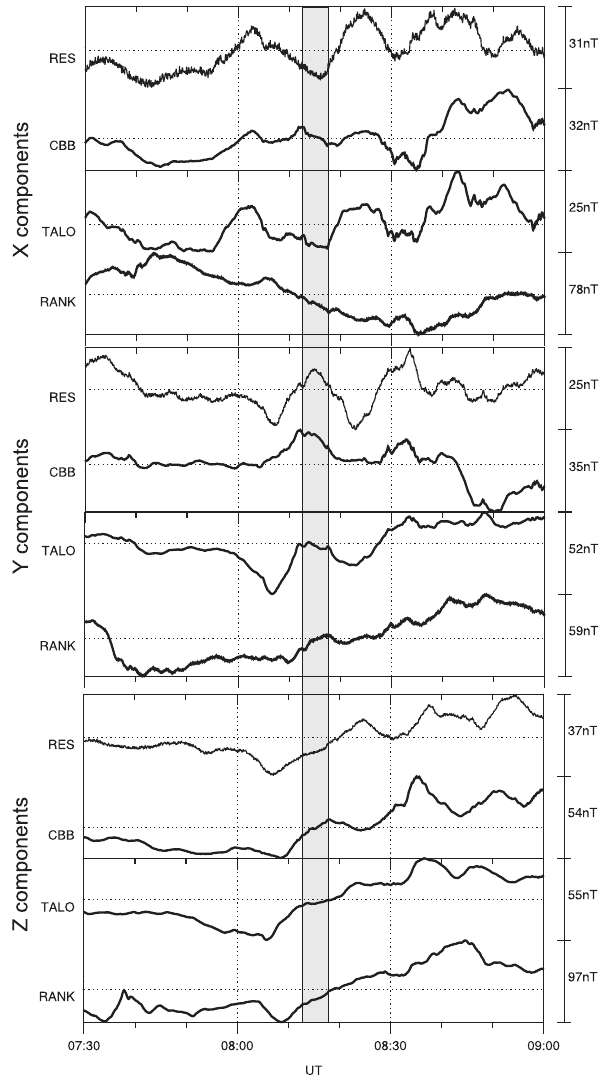
Fig. 9. X, Y and Z components (geographic coordinates) of the Earth magnetic field fluctuations recorded at Resolute Bay (RES), Cambridge Bay (CBB), Taloyak (TALO) and Rankin Inlet (RANK) between 07:30 and 09:00UT on 15 February 2007.